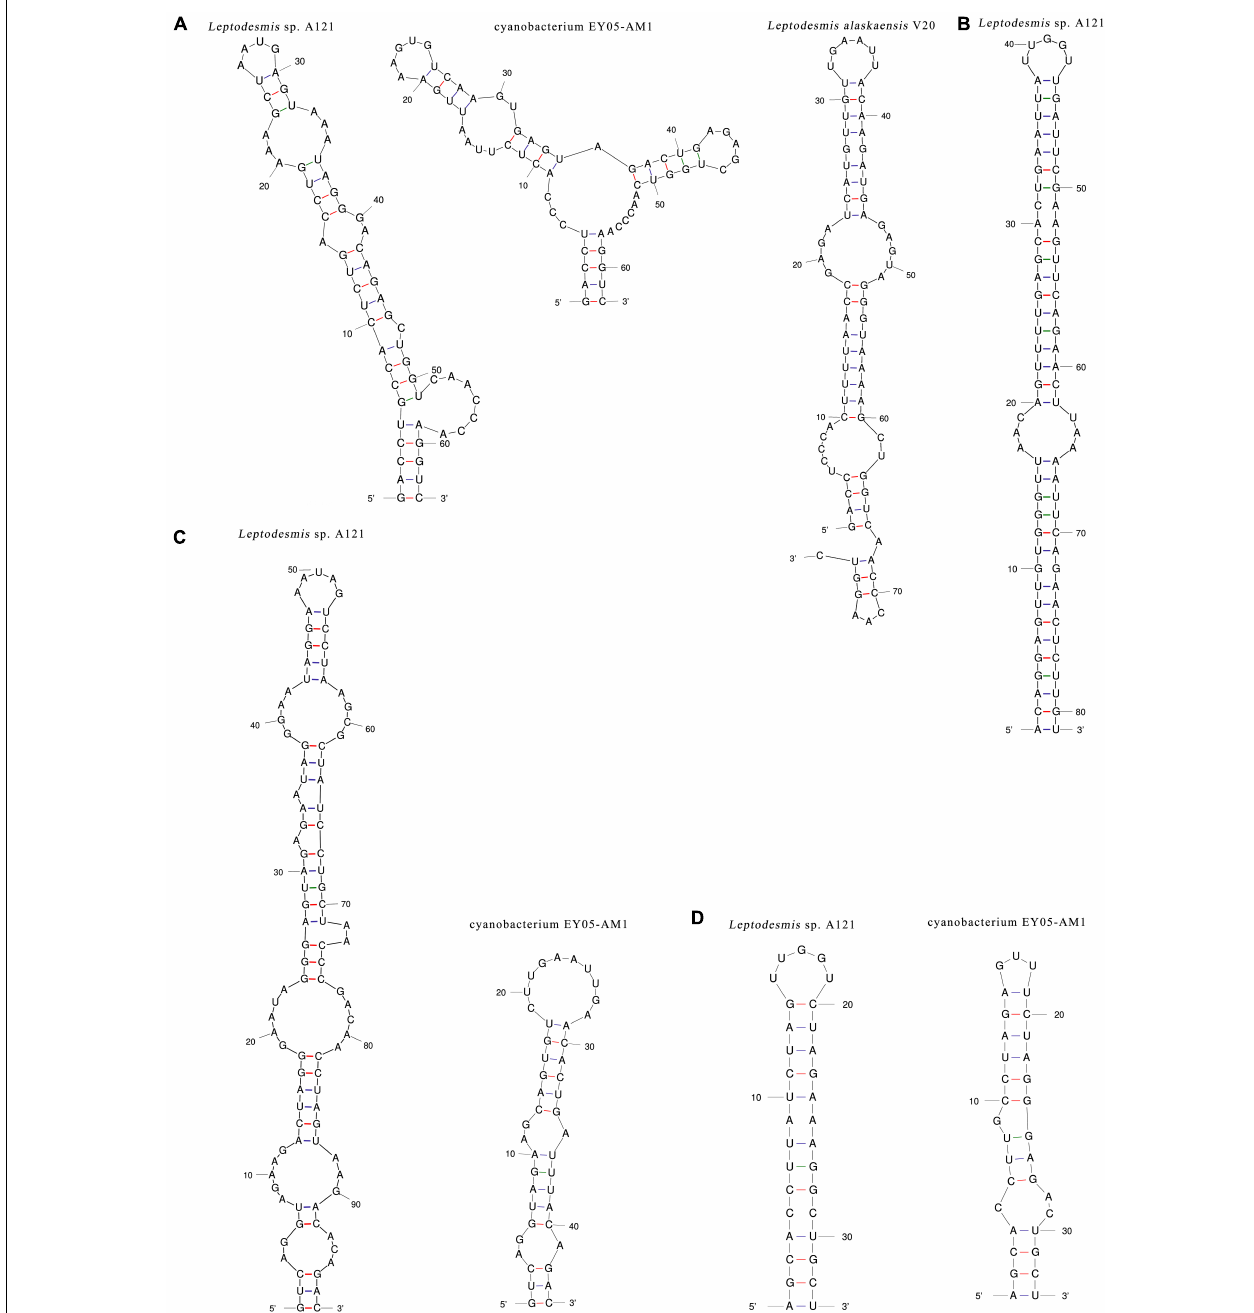
FIGURE 4 | Hypothetical secondary structures of D1-D1 (cid:48) helix (A) , V2 helix (B) , V3 helix (C), and boxB (D) of 16S-23S ITS of Leptodesmis strains.